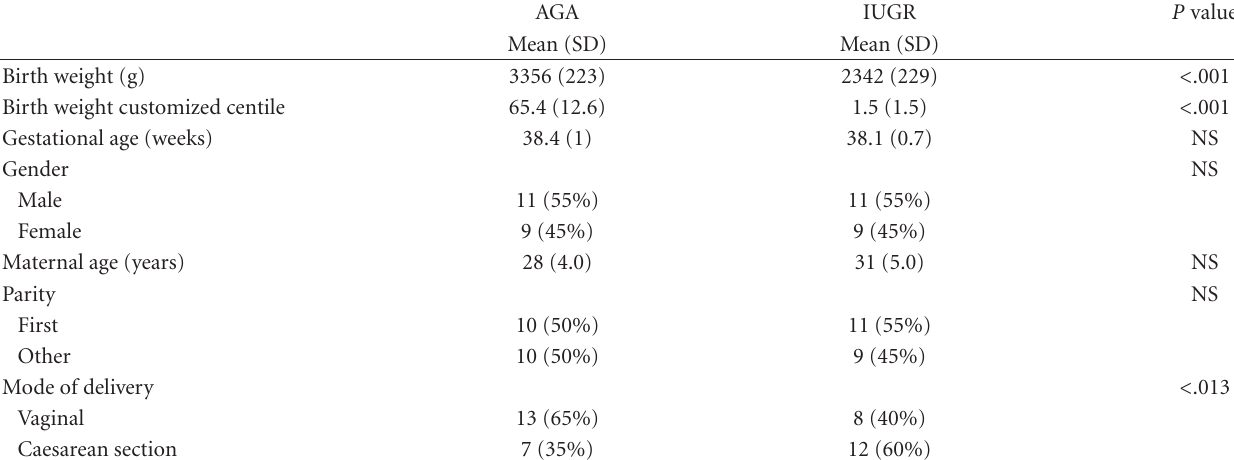
Table 1: Demographic data for appropriate-for-gestational age (AGA) and intrauterine growth-restricted (IUGR) neonates and their moth- ers.